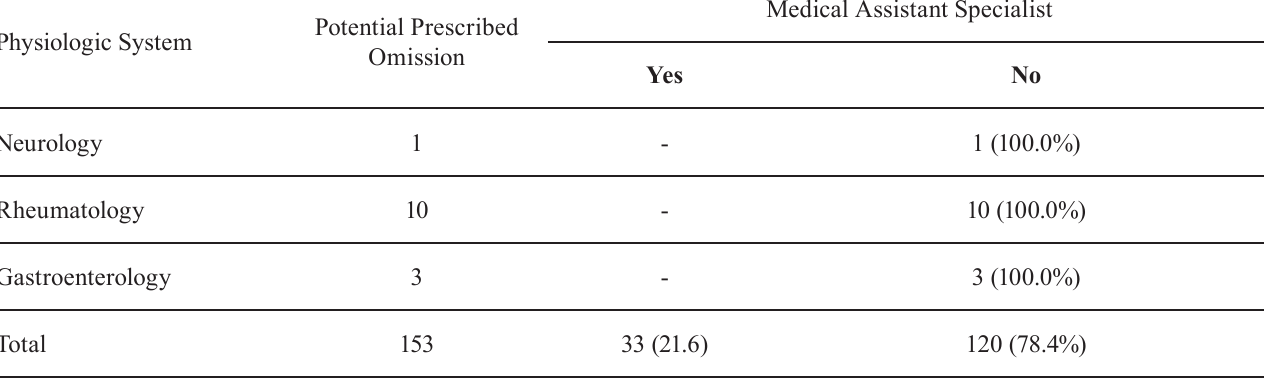
TABLE II – Potential Prescribed Omission according to the START criteria, validated for the Brazilian reality related to the specialty of the prescriber